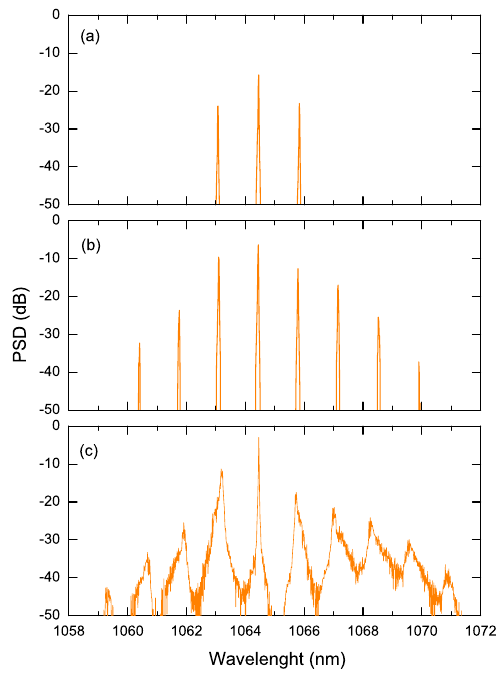
Figure 4: Optical spectra around the fundamental frequency. (a) Above the threshold for the internally pumped OPO a couple of parametric waves appears around the fundamental frequency. (b) Increasing the pump power, new cascaded processes originate new sidebands equally spaced by a multiple of the cavity FSR. (c) Fur- ther increase of power leads to formation of secondary frequency combs around each primary sideband. The secondary comb lines are spaced by the cavity FSR, as verified by radio frequency spectral analysis of the output